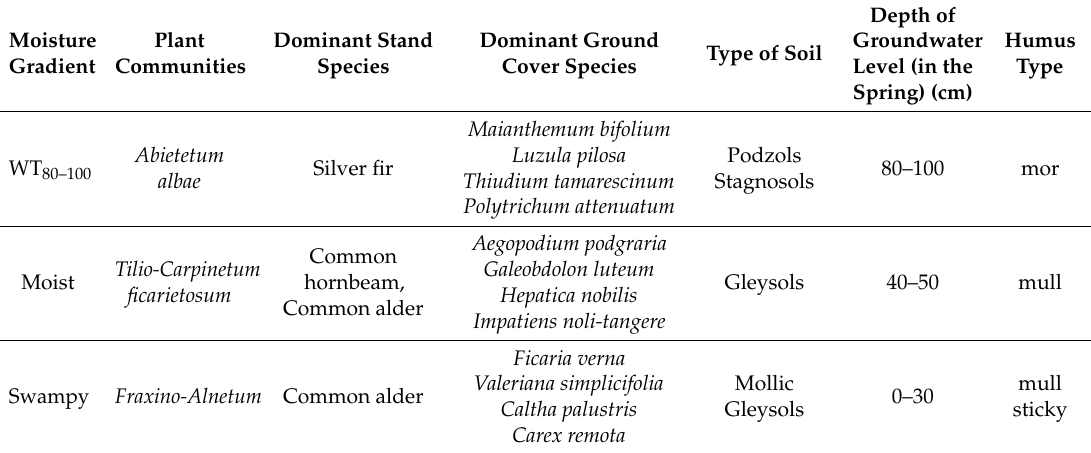
Table 1. Characteristic of vegetation and soils in groups of studied